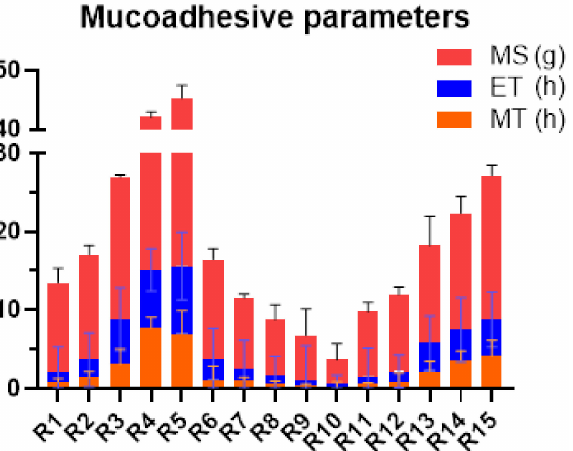
Figure 6. Comparison of the mucoadhesive parameters of the fabricated buccal formulations. Symptoms of redness, inflammation or any irritation were not found from the volun- teers, which suggests that the drug delivery was adaptable in the buccal mucosa without producing local irritation or